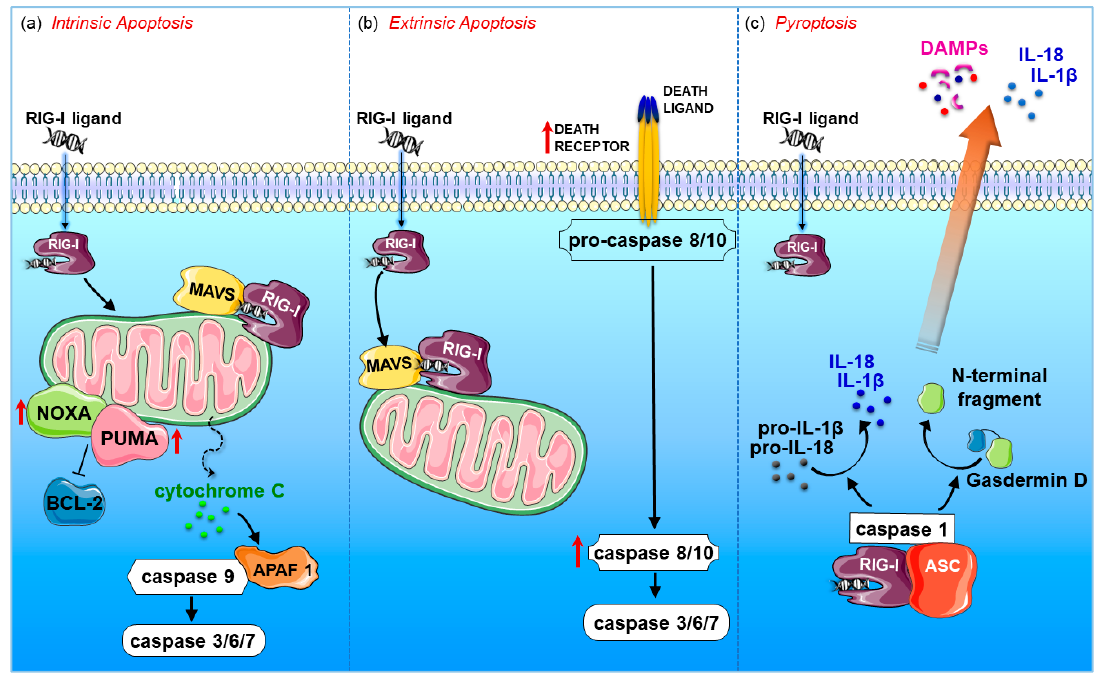
Figure 3. RIG-I activation induces cancer cell death. ( a ) Upon RIG-I activation, expression of the pro-apoptotic genes NOXA and PUMA is upregulated, followed by cytochrome c release out of mitochondria. Subsequent activation of caspase-9 results in execution of intrinsic apoptotic pathway. ( b ) RIG-I signalling can also induce expression of several pro-apoptotic factors including death receptors that trigger extrinsic apoptotic pathway by activating the caspases cascade. ( c ) Activated RIG-I promotes the recruitment of inflammasome adaptor protein ASC and caspase-1, which drives cleavage of pro-IL-1 β and pro-IL-18 and gasdermin D. The N-terminal domain of gasdermin D translocates to the plasma membrane, causing cellular swelling and ultimately pyroptosis. ASC, Apoptosis-associated Speck with a Caspase-recruitment domain; DAMP, danger associated molecular pattern; IL, intereleukin; MAVS, mitochondrial anti-viral signalling.